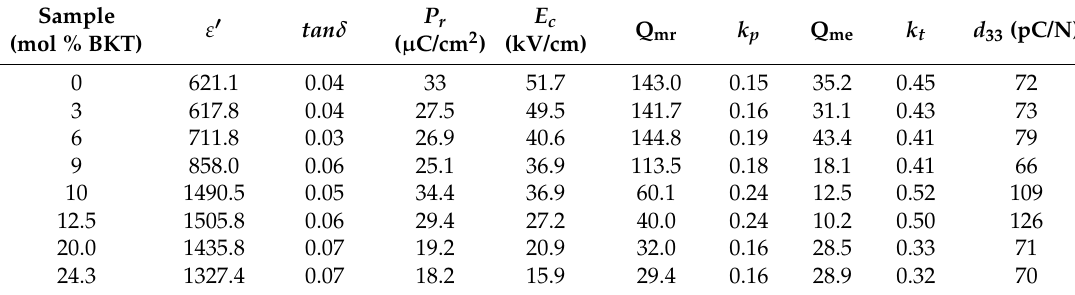
Table 2. Dielectric, ferroelectric, and piezoelectric properties of the BNT-BKT-BT prepared samples.